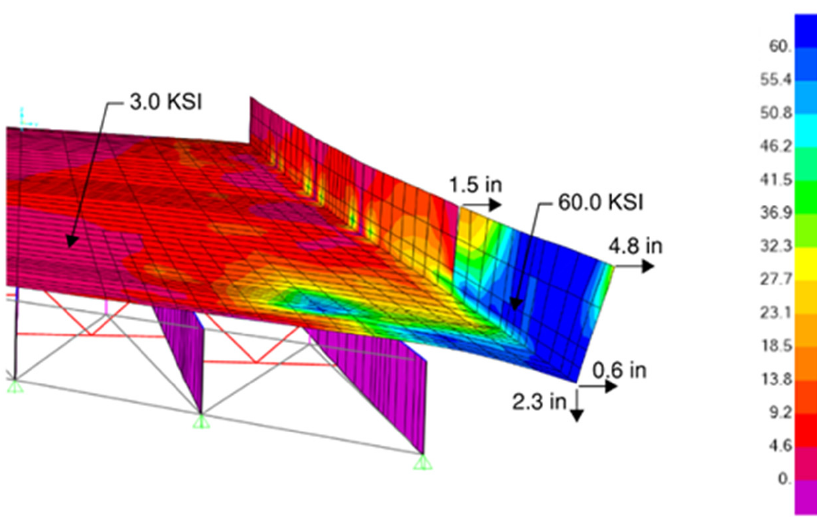
Figure 13. The deformed shape of an end segment under Design Case 1.